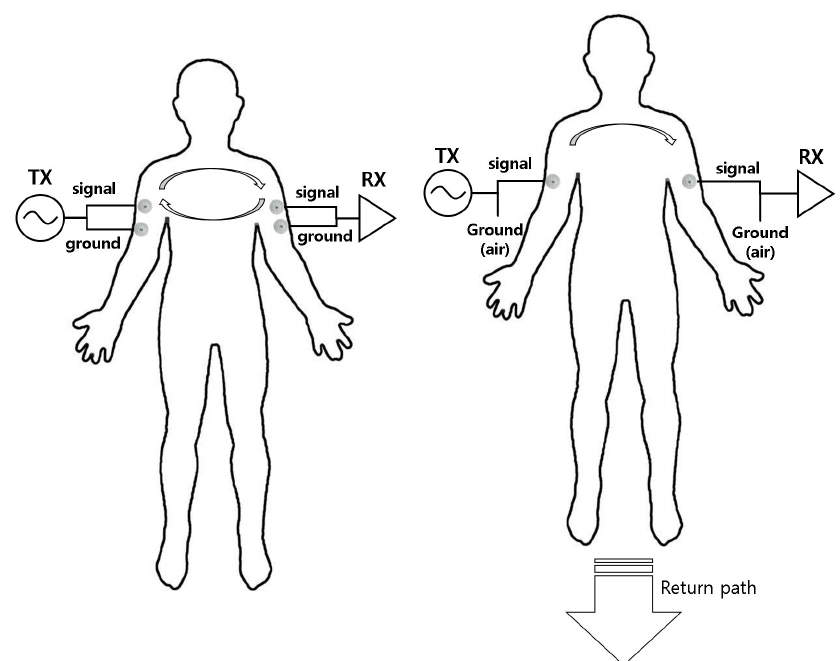
Figure 1. Coupling in an IBC